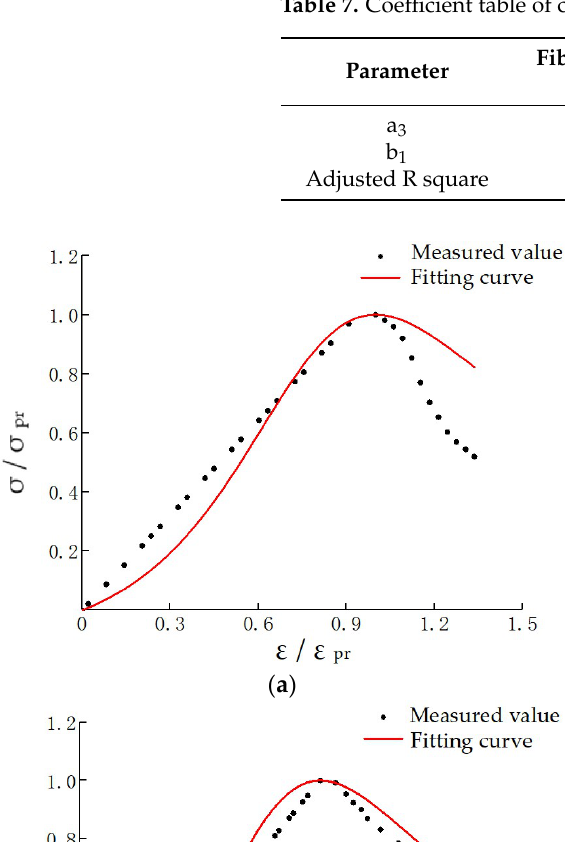
Table 7. Coefficient table of constitutive equation of soil sample under uniaxial compression.